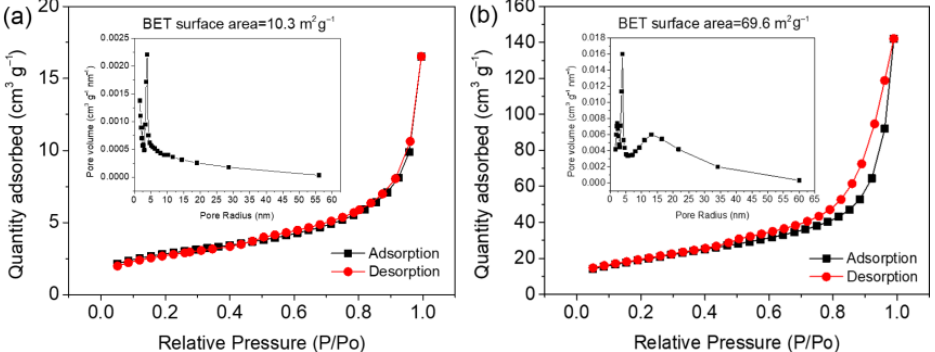
area of SnO 2 @Ni 6 MnO 8 is as high as 69.6 cm 2 g −1 compared to SnO 2 @C (10.3 m 2 g −1 ). The